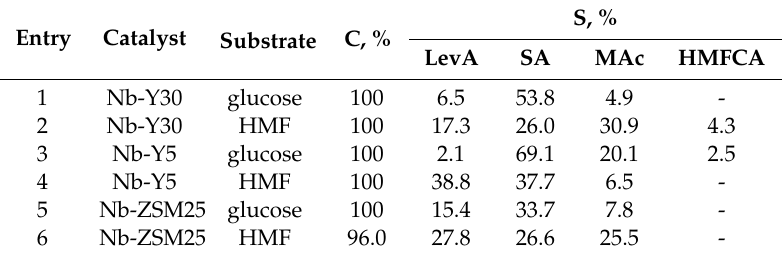
Table 4. The variation of the HMF conversion (C, %) and selectivites (S, %) to the main reaction products in the aqueous oxidation of HMF on Nb-based zeolite catalysts. Entry